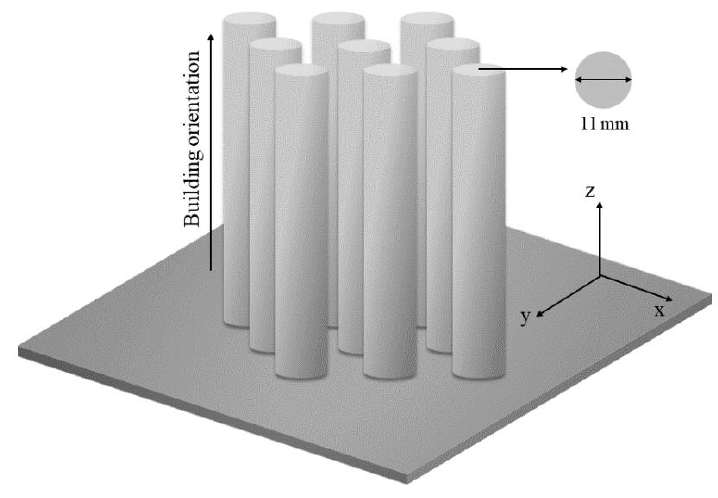
Figure 3. The building orientation of SLM TC4 samples.